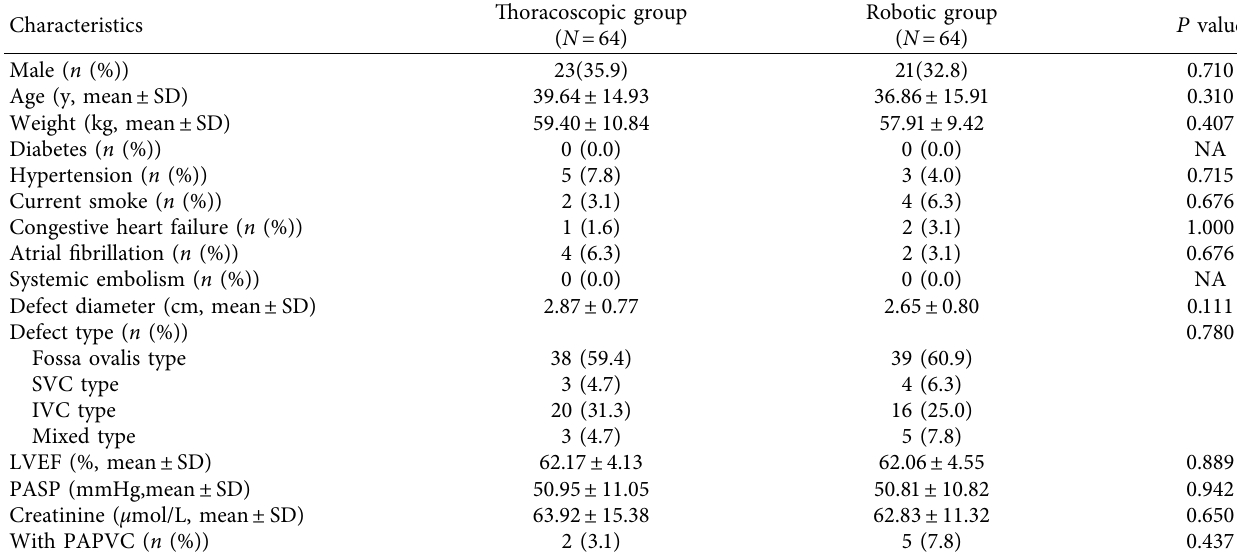
Table 2: Patient baseline characteristics after propensity matching.